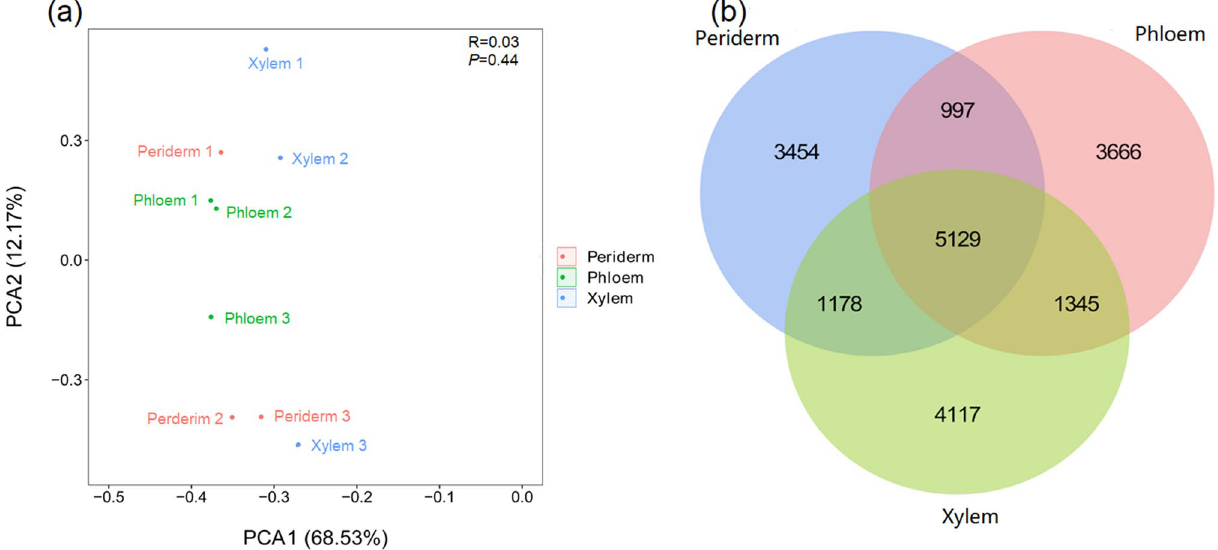
Figure 3. ( a ) Principal component analysis (PCA) and ( b ) Venn profiles in the roots of S. flavescens